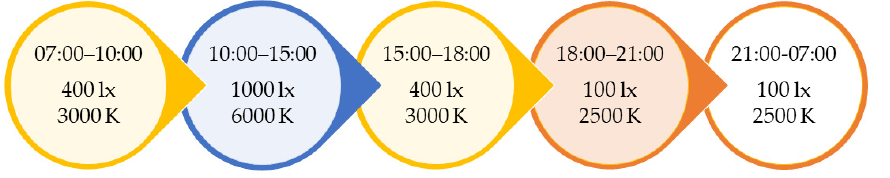
Figure 1. Illuminance (lx) and correlated color temperature (kelvin, K) at different times of the day in the intervention group, with gradual transition periods of 30 min separating each phase. Between 21:00 and 07:00 the lights could also be turned off by staff if this was